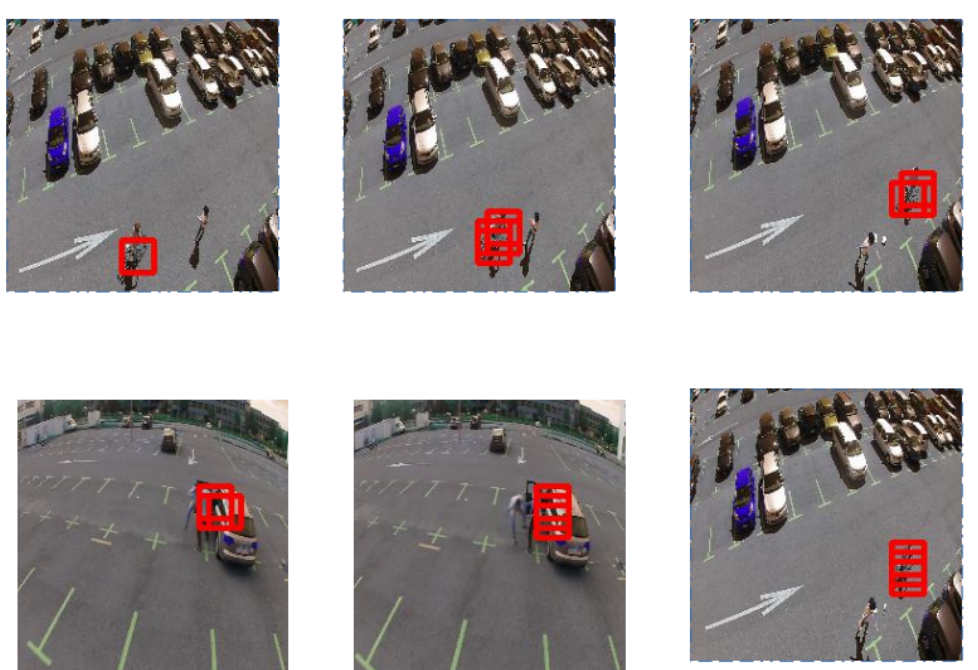
Figure 7. Our results on the MDVD dataset.